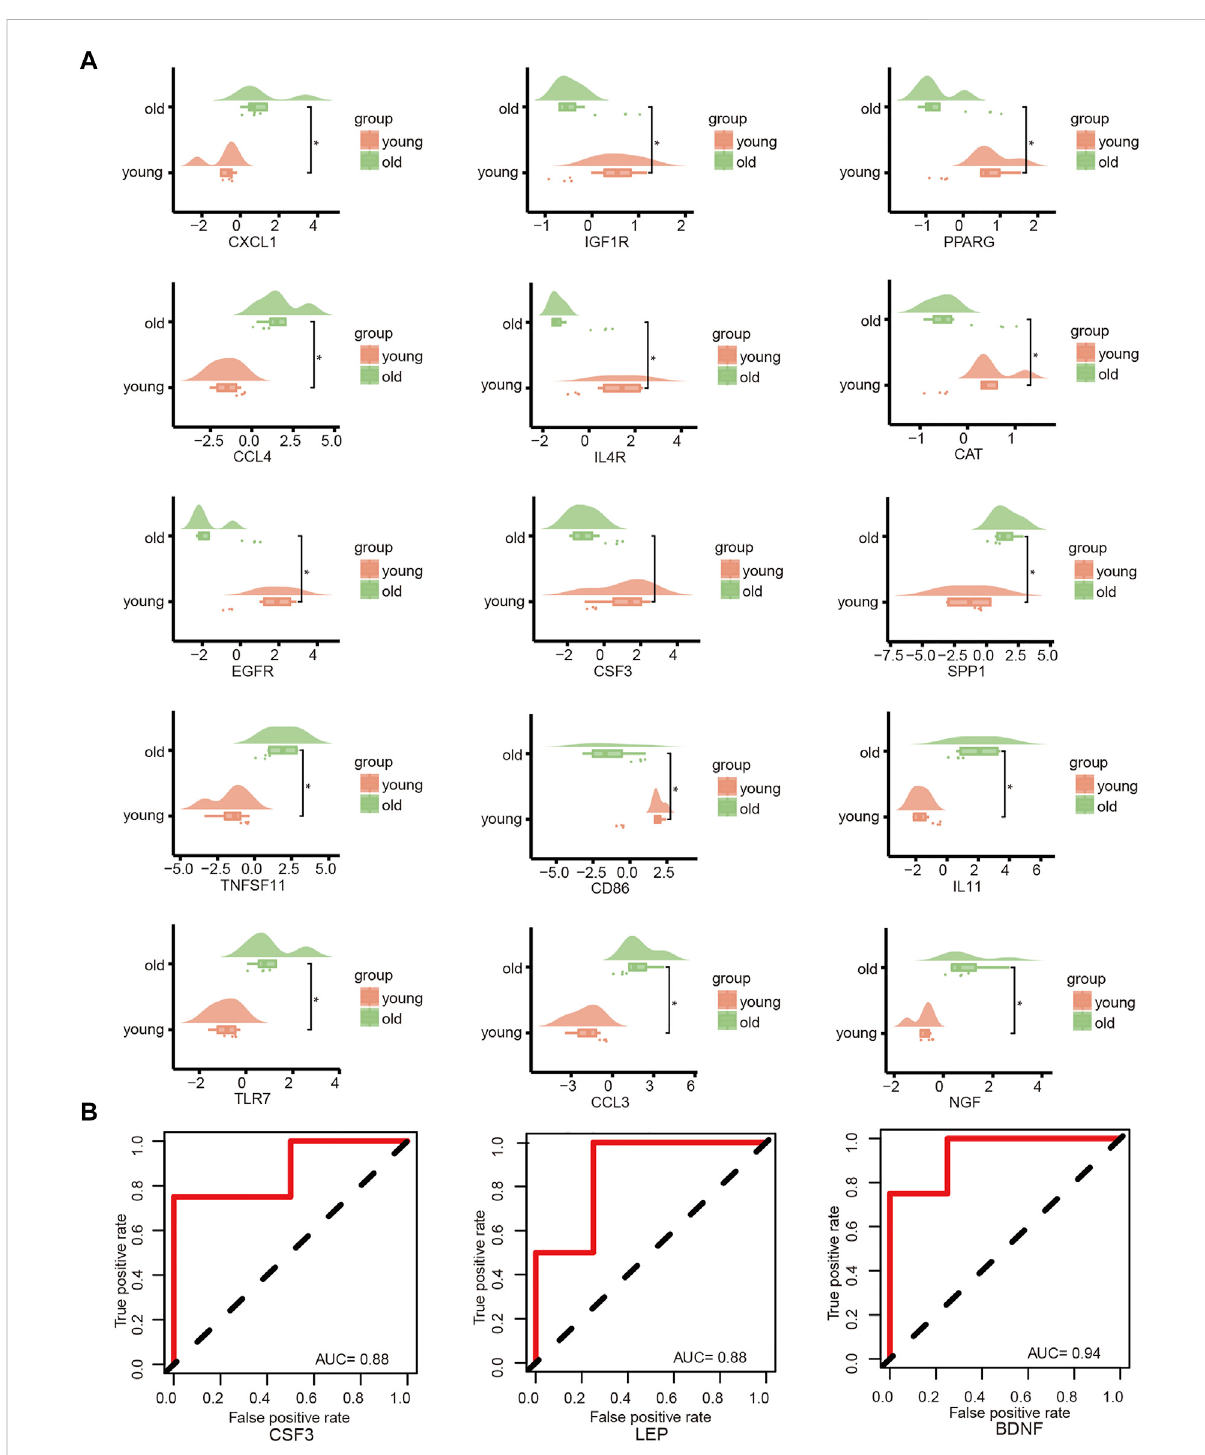
FIGURE 8 Key gene analysis. (A) Cloud and rain plots show the expression differences of LFH immune-related DEGs in the elderly and young groups; vertical coordinates indicate the grouping and horizontal coordinates the expression levels of the different DEGs. (B) ROC curves of the key genes CSF3 , LEP , and BDNF in the GSE113212 dataset; only genes with AUC values above 0.7 are